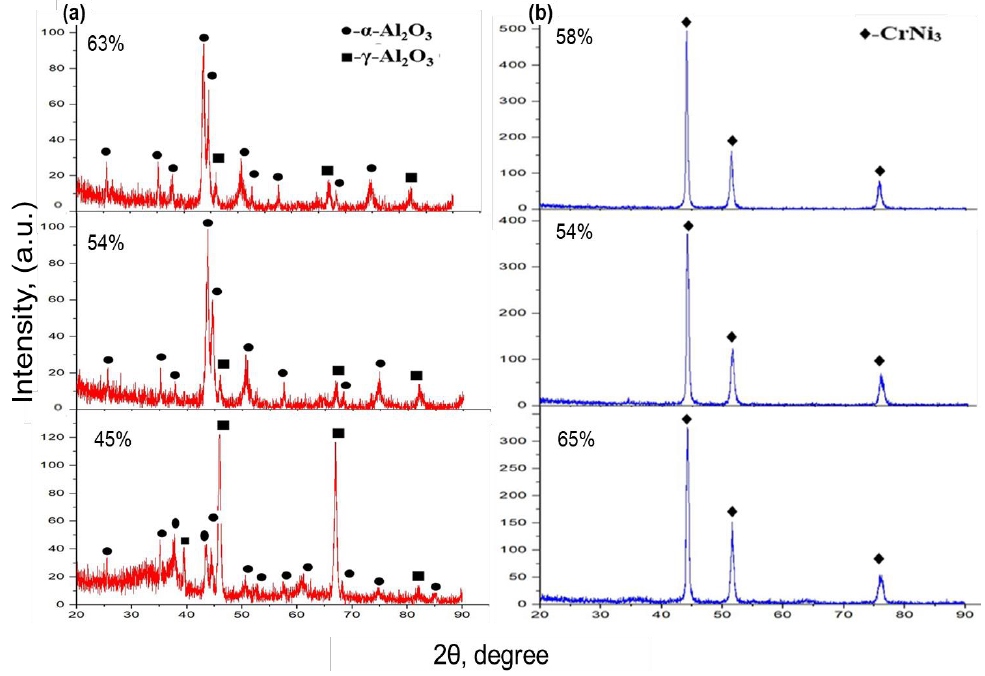
Figure 2. Diffractograms of Al 2 O 3 ( a ) and NiCr ( b ) coatings obtained at different barrel filling volumes with an explosive gas mixture.